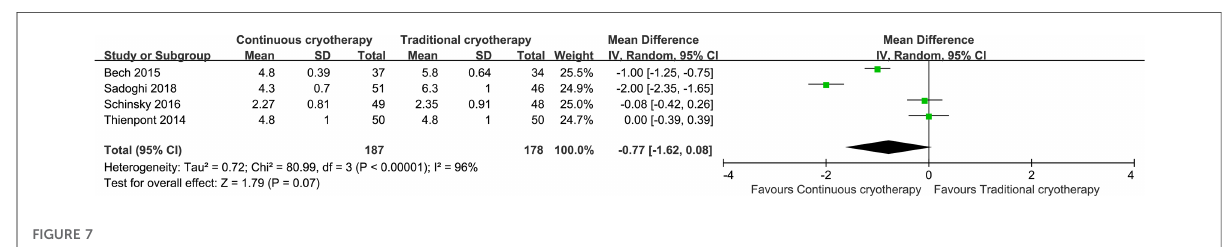
FIGURE 7 Forest plot for the length of hospital